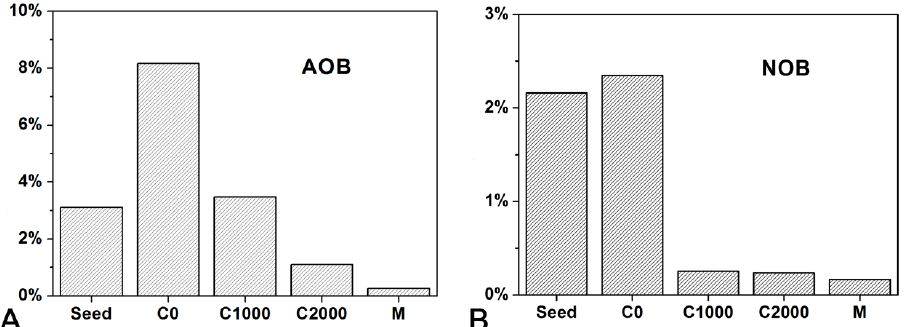
Figure 7. Variation of the relative abundance of ( A ) AOB and ( B )